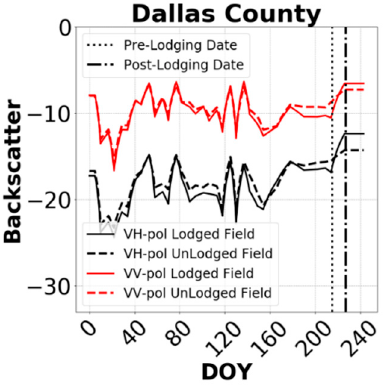
Figure 14. Time series of lodged and un-lodged fields in Dallas county, Iowa.